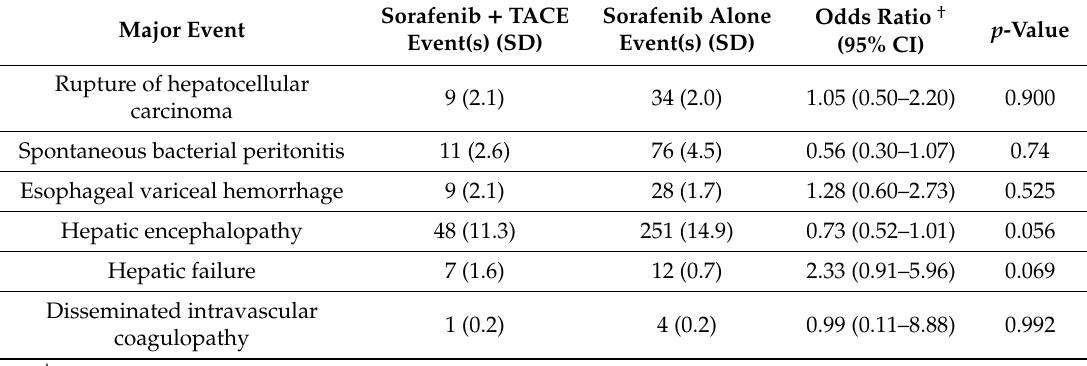
Table 3. Major complications or adverse events.